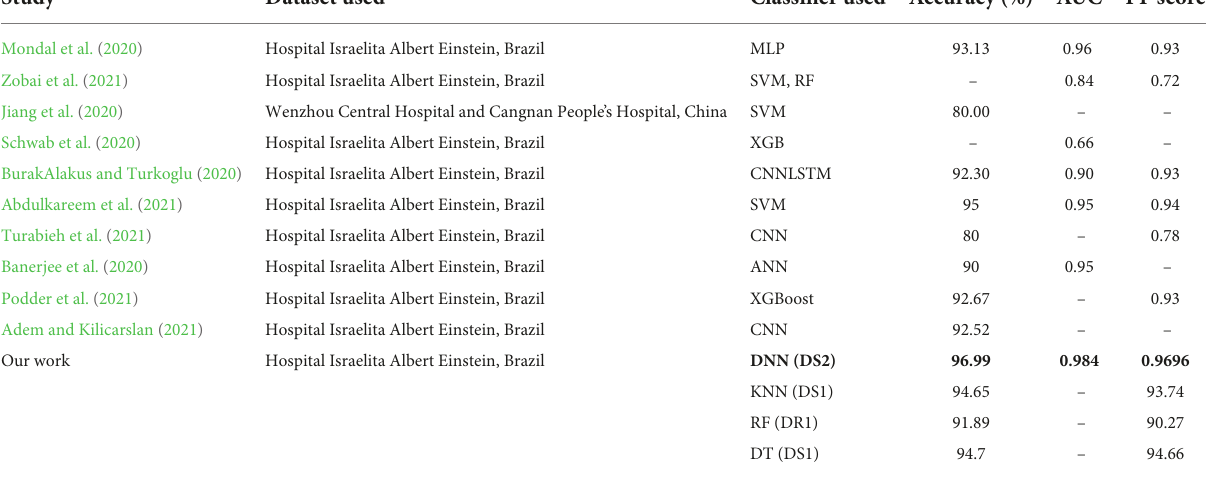
TABLE 9 Comparison of results with other research work.